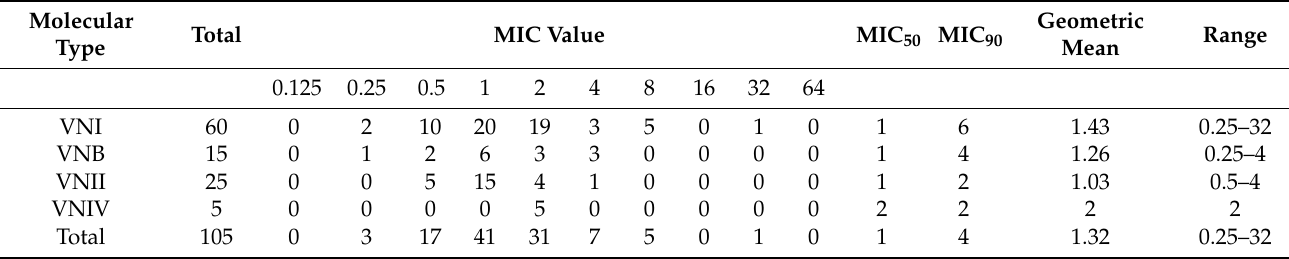
Table 1. Fluconazole minimum inhibitory concentration (MIC) distribution (in µ g/mL) by molecular type of 105 South African Cryptococcus neoformans isolates from national laboratory-based cryptococcosis surveillance collected between 2005 and